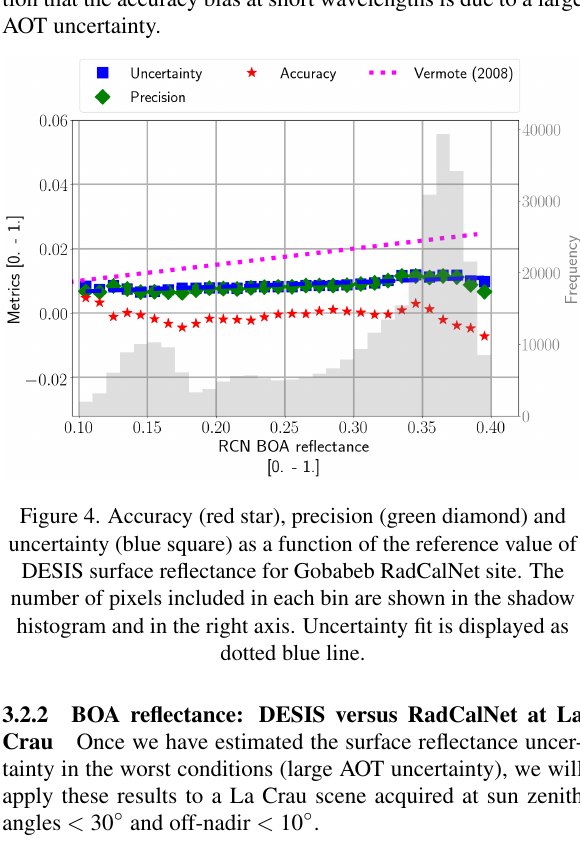
Figure 3. Accuracy (red star), precision (green diamond) and uncertainty (blue square) as a function of the reference value of DESIS surface reflectance for Gobabeb RadCalNet site. The number of pixels included in each bin are shown in the shadow histogram and in the right axis. Uncertainty fit is displayed as dotted blue line. The dashed blue line is the resulting linear fit to the uncertainty curve, U BOA = (0 . 04 ± 0 . 02) · ρ BOA + (0 . 011 ± 0 . 006) . The large offset (0.011 ± 0.006) compared with Landsat-8 ref- erence value (0.005) (Vermote and Kotchenova, 2008) plotted as pink dashed line (Figure 3) is due to the accuracy bias at low frequencies ( λ < 440 nm ).